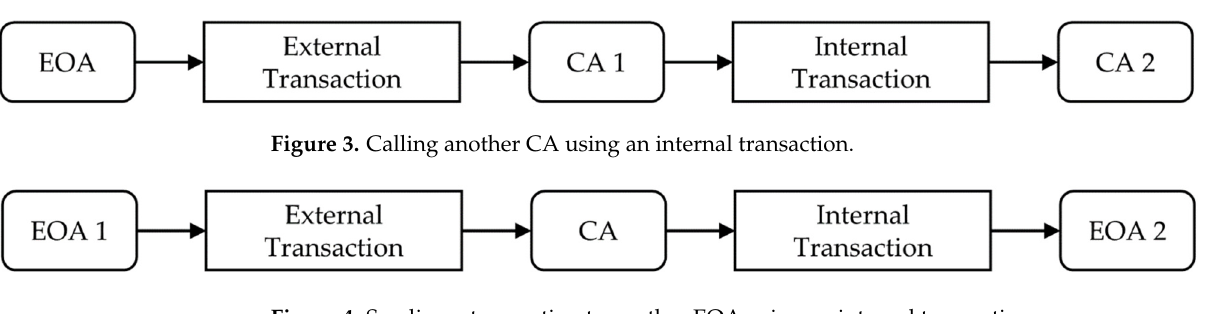
Figure 4. Sending a transaction to another EOA using an internal transaction. Figure 3. Calling another CA using an internal transaction.